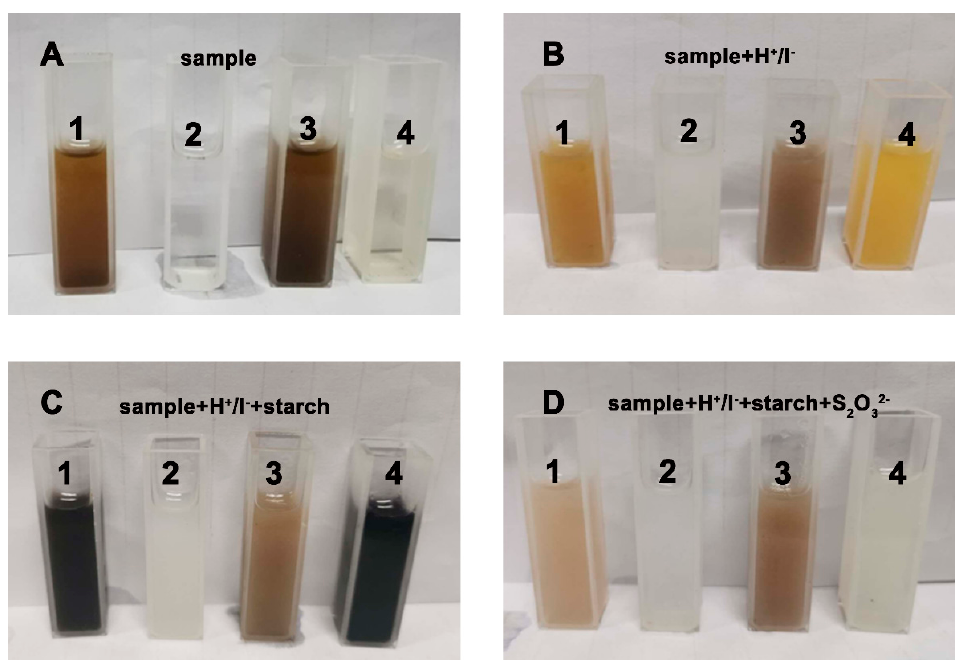
Figure 7. Color changes in (1) PAN/GO/DCDMH, (2) PAN, (3) PAN/GO, and (4) PAN/DCDMH during the iodometric/thiosulfate assay: ( A ) sample suspension; ( B ) sample + H + /I − system; ( C ) sample + H + /I − + starch system; ( D ) sample + H + /I − + starch + S 2 O 32 − system.